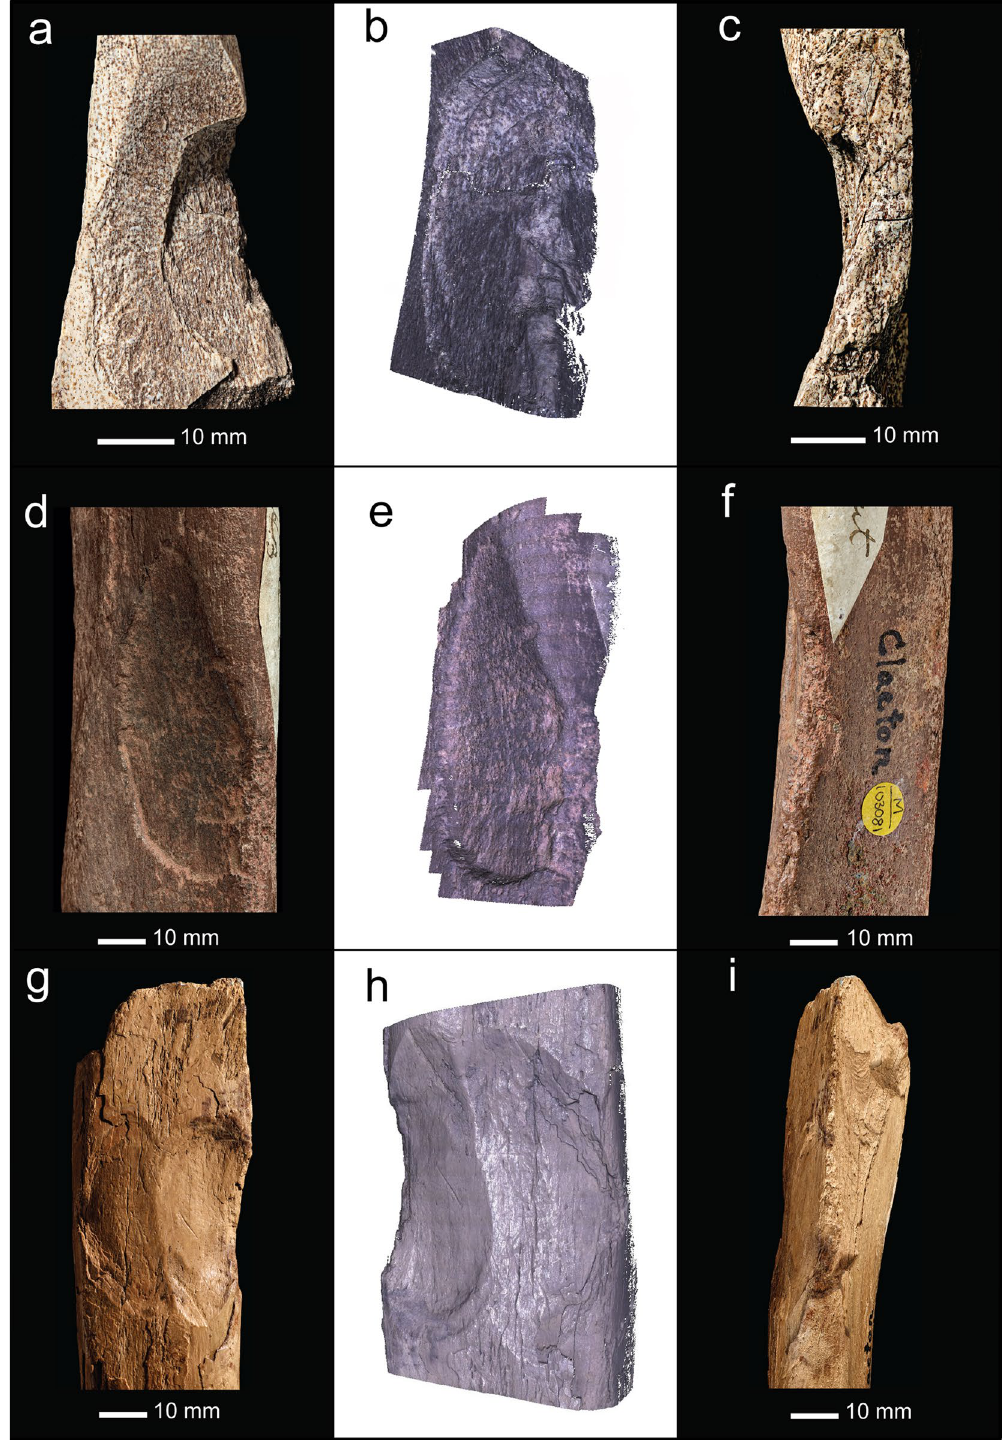
Figure 11. Comparison of flaking of the Boxgrove percussor fragment ( a – c , NHMUK PV M 103370) with flake removals on the shafts of the rhinoceros radius ( d – f , NHMUK PV M 103081), and deer tibia ( g – i , NHMUK PA E 7492) from Clacton. The Alicona images are oriented to show battering damage, which is well preserved in the Boxgrove example but partly covered by matrix in the rhinoceros radius; it is not possible to estimate the extent of damage to the tibia because weathering has removed the outer surface of the cortical bone in the critical